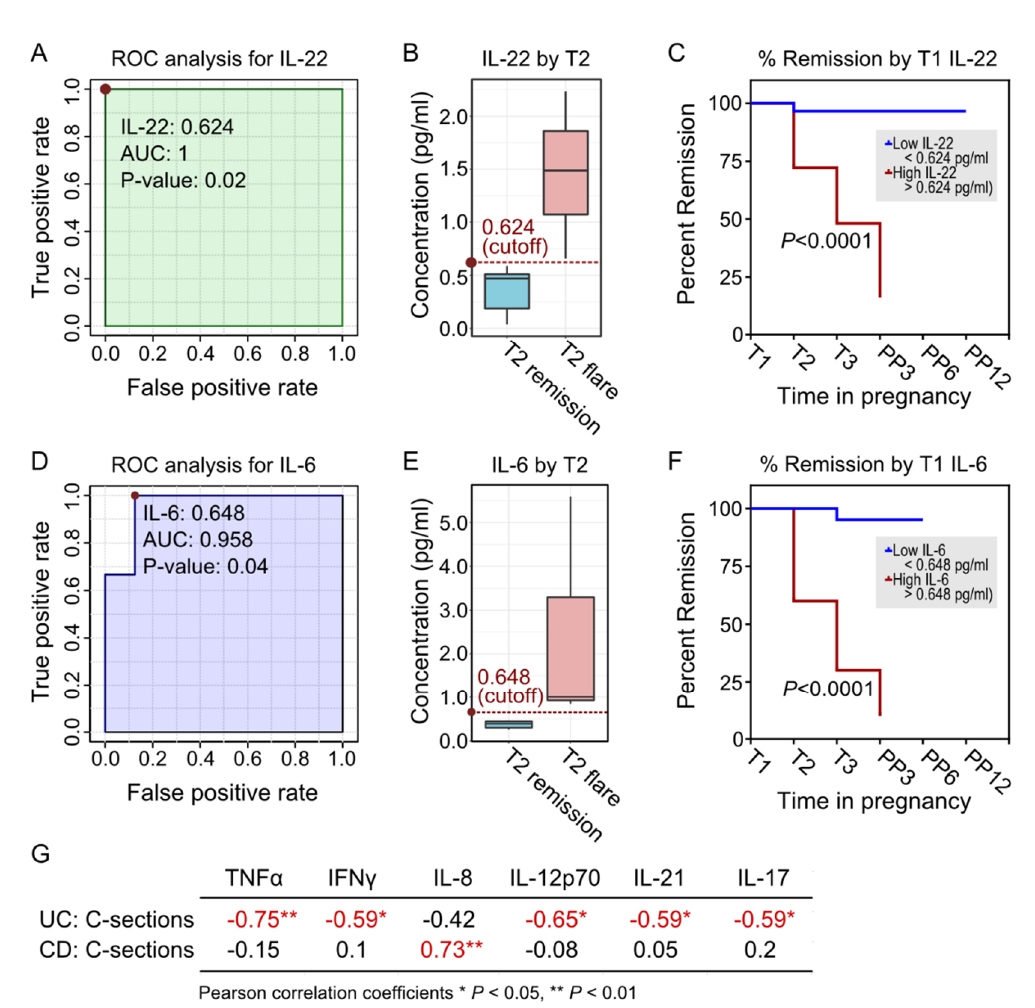
Figure 5. Predictive utility of T1 maternal serum cytokines in predicting the course of IBD disease during pregnancy. ( A ) ROC analysis using serum IL-22 levels at T1 at a cut-off of ( B ) 0.624 is associated with active disease activity at T2 in women with UC (AUC = 1, p = 0.02). ( C ) Percent remission curves of UC patients with known T1 IL-22 levels throughout pregnancy stratified based on IL-22 levels (N = 12). ( D ) ROC analysis using serum IL-6 levels at T1 at a cut-off of ( E ) 0.648 is associated with active disease activity at T2 in women with CD (AUC = 0.958, p = 0.04). ( F ) Percent remission curves of CD patients with known T1 IL-6 levels throughout pregnancy stratified based on IL-6 levels (N = 15). ( G ) Pearson correlation coefficients correlating T1 serum cytokines with obstetrical outcomes at time of delivery. * denotes p < 0.05, ** denotes p <